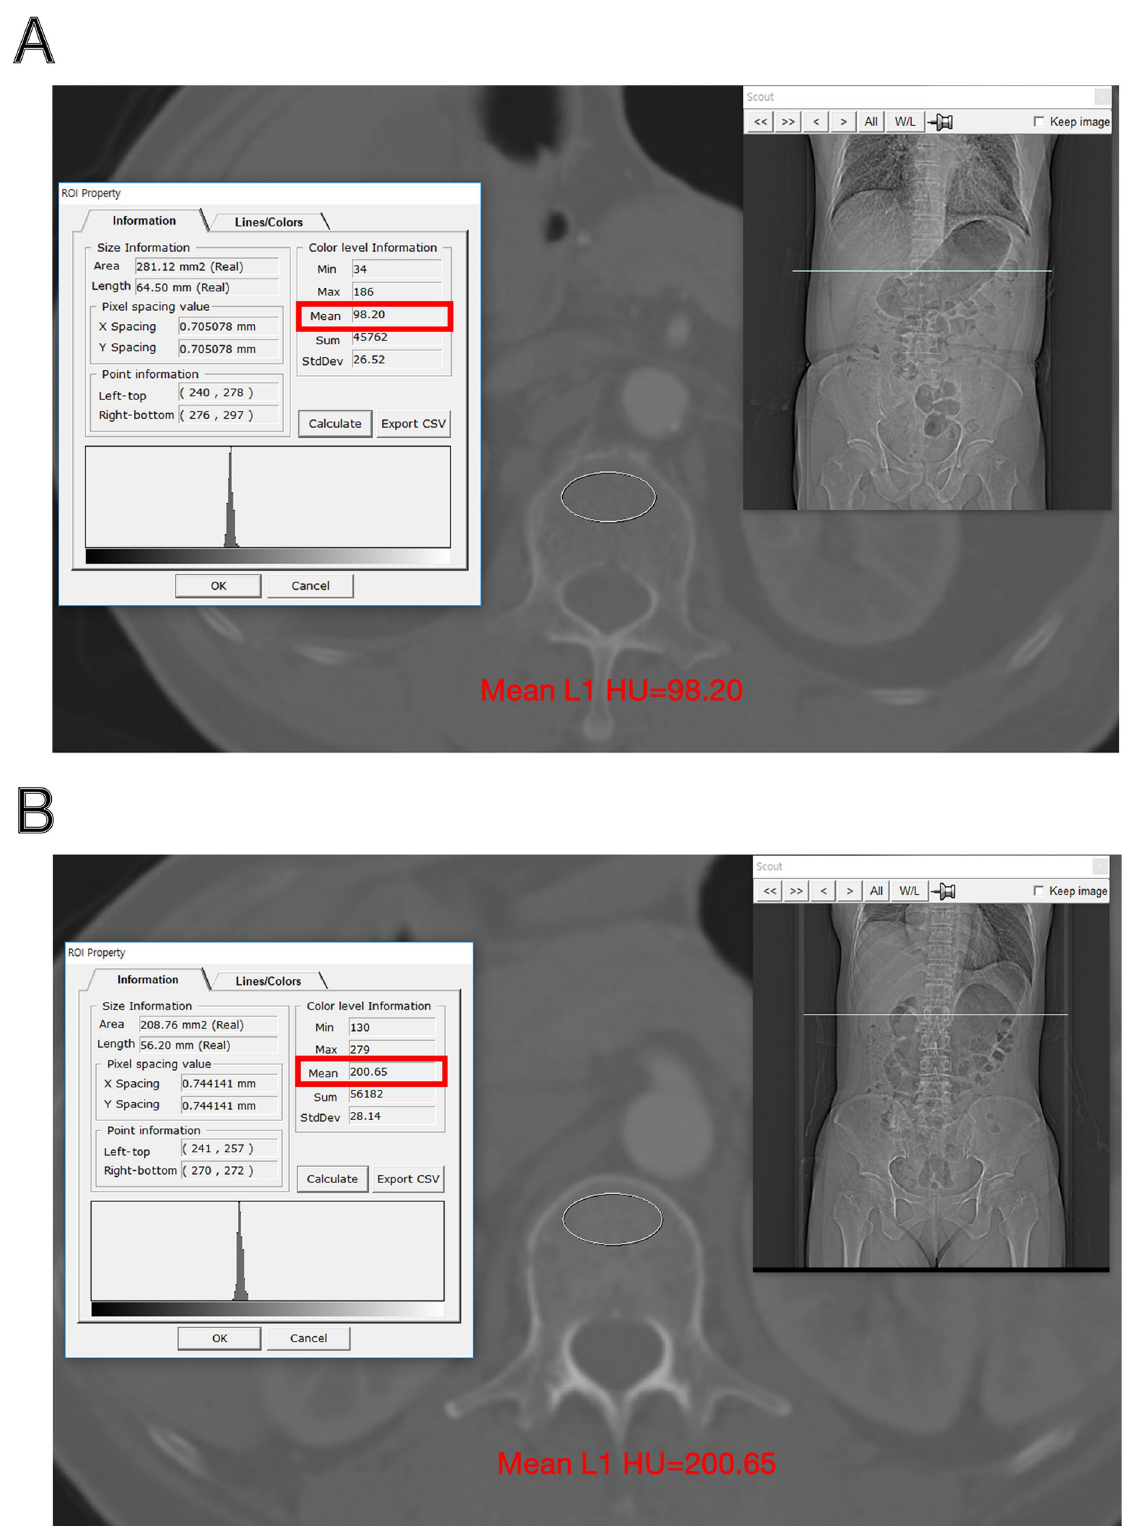
Fig 1. Examples of measurement of HU values in the trabecular bone of the middle of the L1 vertebral body. The PACS automatically calculates the mean HU value according to ROI line, and the mean HU value is recorded. (A) CT showing relatively low mean L1 HU value;